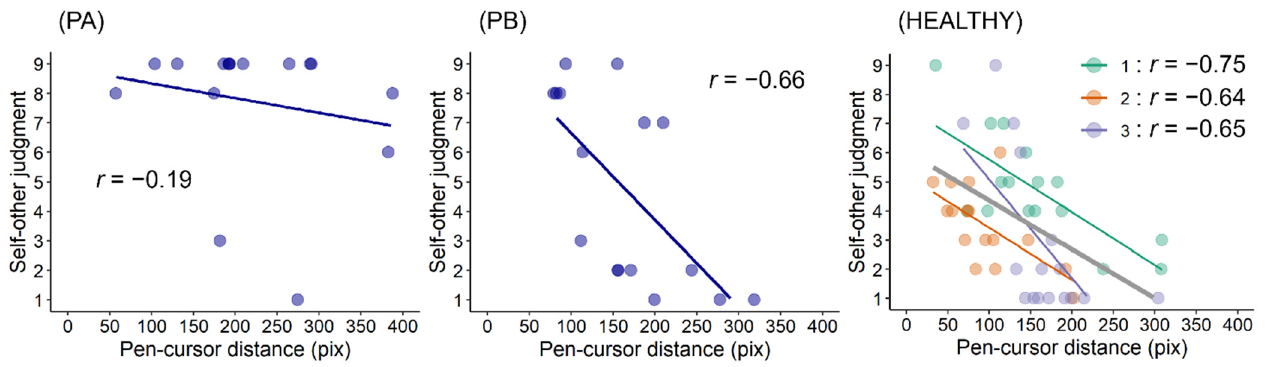
Figure 4. Incorrect responses in self-other judgments. In the FAKE condition, the incorrect response score in PA (6.75) was higher than that in PB (3.75) or healthy participants (3.75; 2.50; 1.88). PB (and one healthy participant) made no incorrect responses in the SELF condition. Grey line shows the mean score in healthy participants.